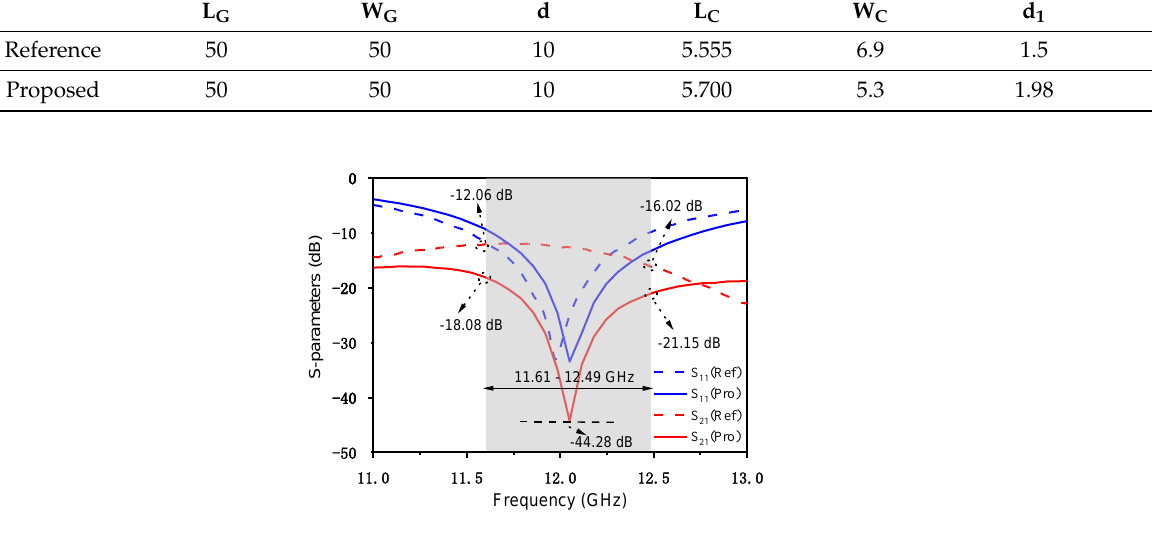
Figure 7. Measured S − parameters of reference and proposed design.